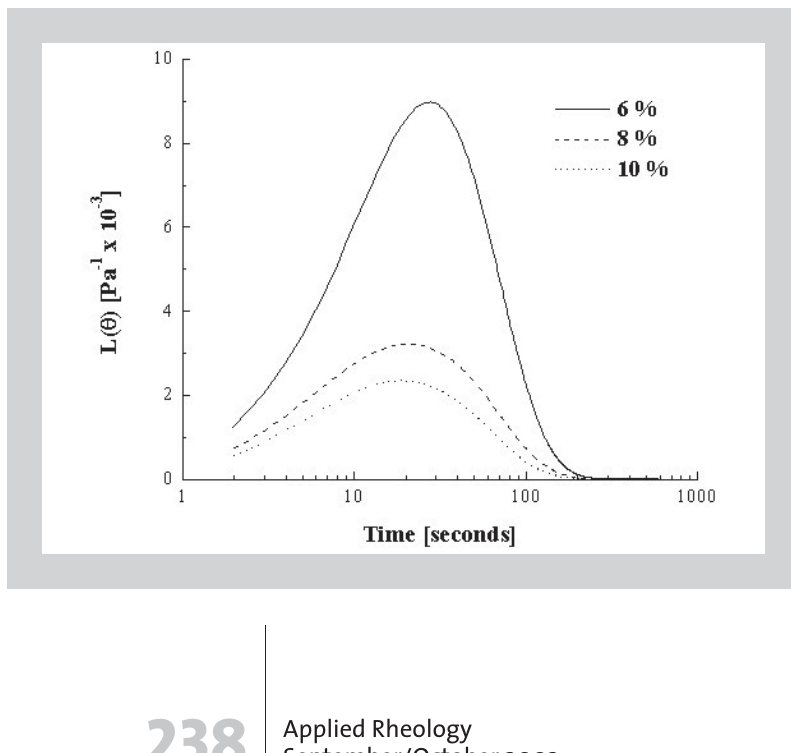
Figure 4: continuous retardation spectra for different bentonite concen- trations (7, 8 and 10 wt%). Note that 5 and 6 wt% concentrations are not plotted here for ease of legibility of the graph. Values of maxima spectra are as follows: 75 x 10 -3 Pa -1 (5 wt%) and 15 x 10 -3 Pa -1 (6